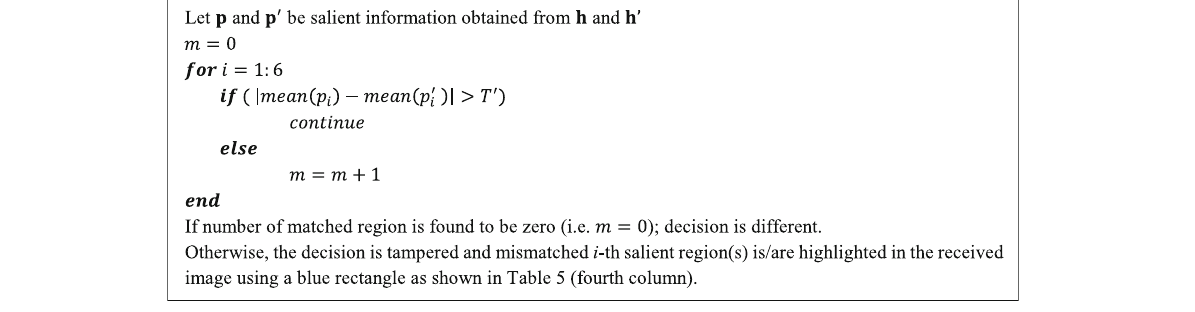
Table 1 Pseudocode for tamper